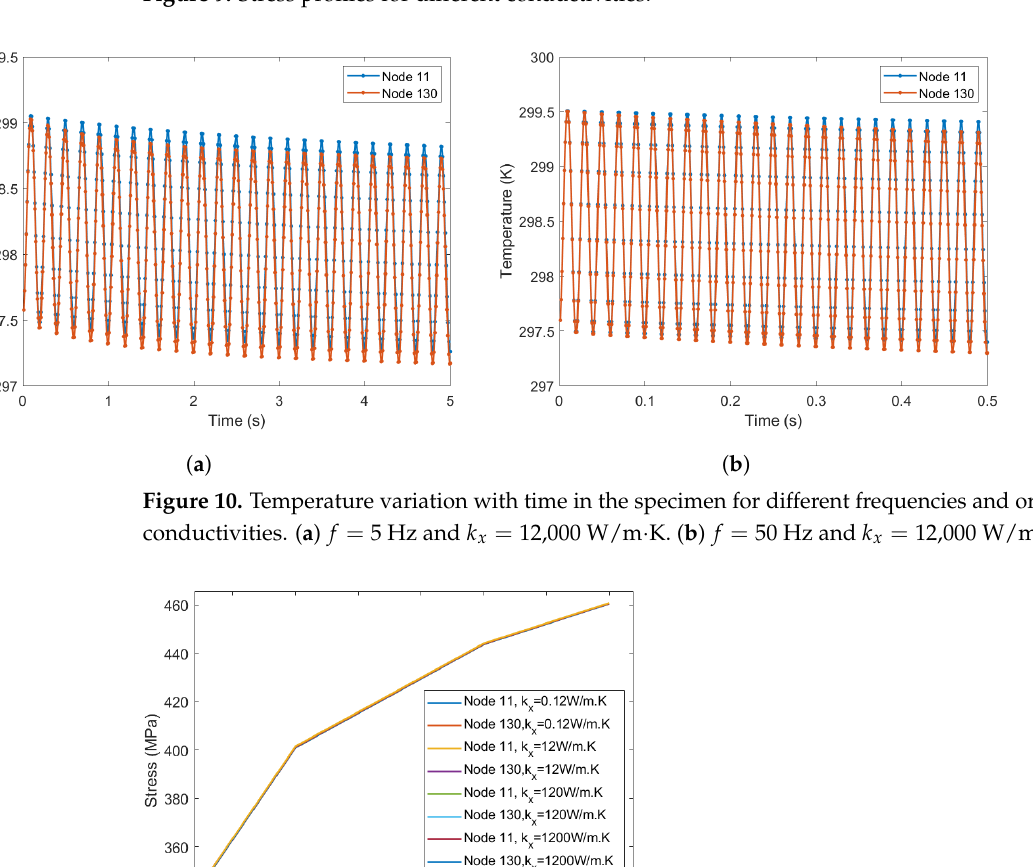
Figure 9. Stress profiles for different conductivities.